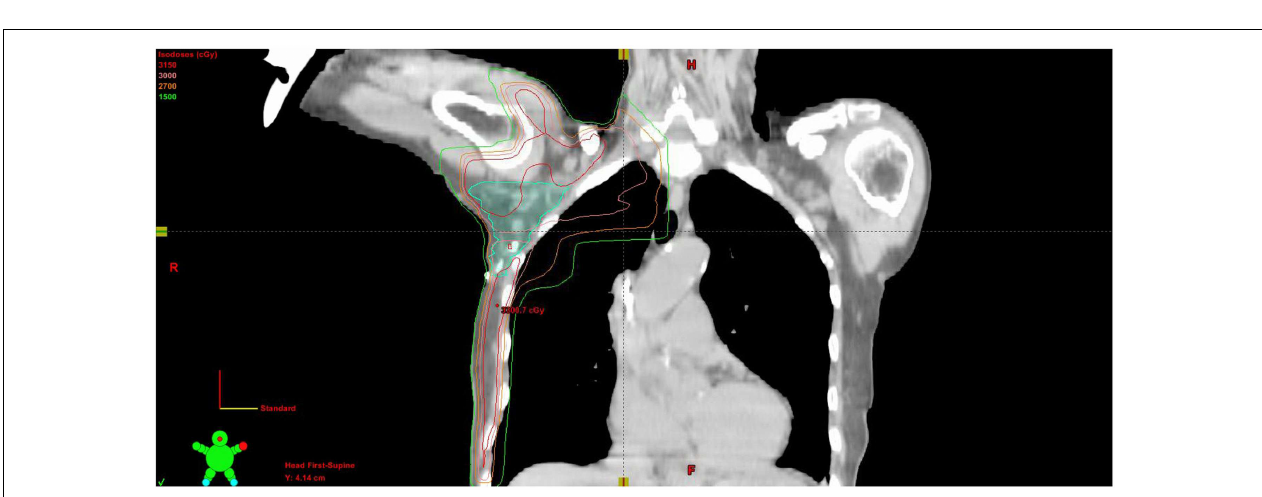
FIGURE 5 | Coronal CT slice of treatment plan showing isodose lines and contoured axillary nodal volume .